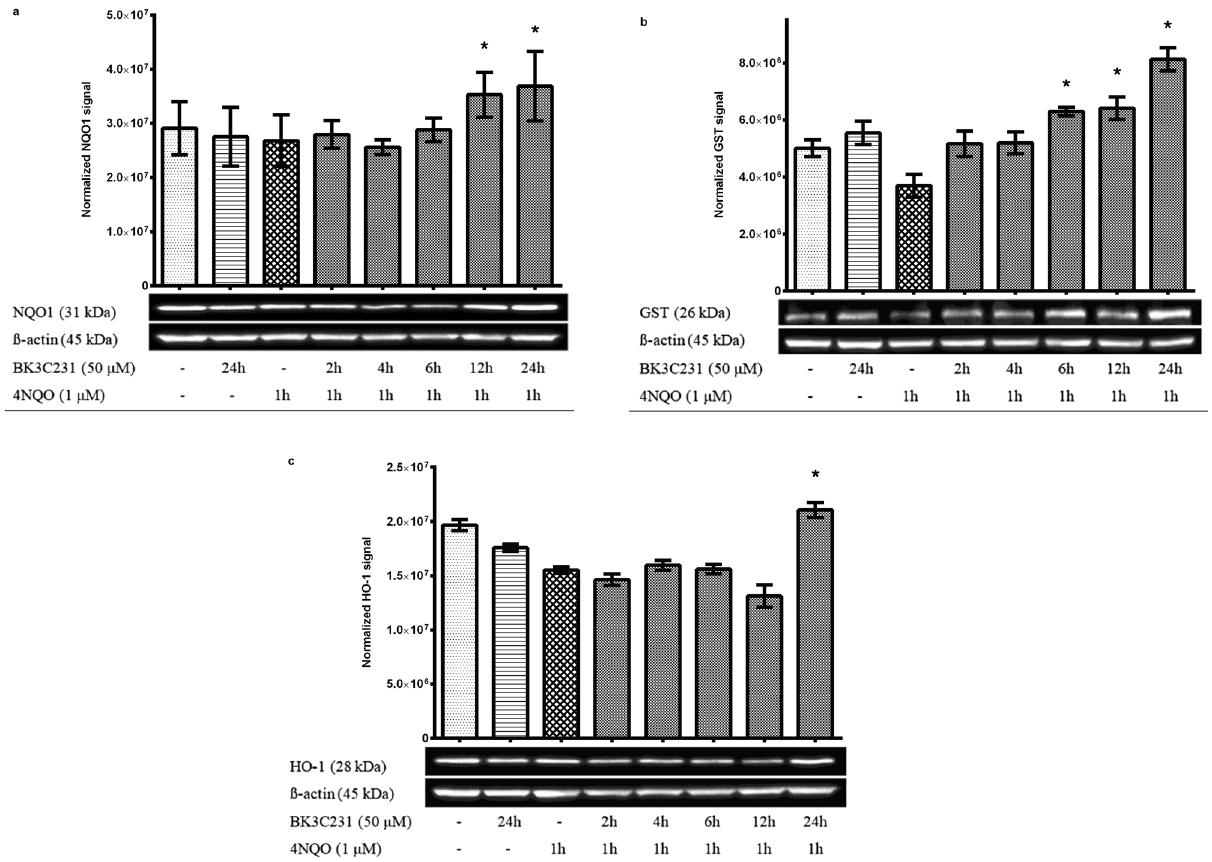
Figure 2. Effect of BK3C231 pretreatment on the protein expression of cytoprotective enzymes namely NQO1 ( a ), GST ( b ), and HO-1 ( c ). Basal-level constitutive expressions of NQO1, GST and HO-1 were observed in untreated control cells and cells treated only with BK3C231. In cells treated only with 4NQO, the expression level of cytoprotective enzymes decreased as compared to that of untreated control. Pretreatment of cells with BK3C231 before 4NQO exposure significantly increased the protein expression of cytoprotective enzymes at 12 h and 24 h for NQO1; 6 h, 12 h and 24 h for GST; and 24 h for HO-1 as compared to that of cells treated with 4NQO only. Treated whole cell lysates were subjected to immunoblotting analysis to determine the protein expression level of NQO1, GST, and HO-1. Each data point was expressed as mean ± SEM from at least three independent experimental replicates. *p < 0.05 against 4NQO 1 h. The blots displayed in the figure are cropped. Full-length blots are presented in Supplementary Figure Pretreatment of cells with BK3C231 for 24 h before 4NQO exposure significantly increased NQO1 activity up to fivefold at 74.76 ± 12.76 nmol/min/mg as compared to that of 4NQO-treated cells at 12.41 ± 2.72 nmol/ min/mg. The enhancement of the NQO1 activity level by BK3C231 was almost 2 times higher than the basal level with a value of 42.81 ± 10.65 nmol/min/mg (Fig. 1a). As for GST activity, our study demonstrated a 1.3- fold increase from 0.48 ± 0.08 µmol/min/mg in 4NQO-treated cells to 1.11 ± 0.14 µmol/min/mg in BK3C231- pretreated cells for 24 h. BK3C231 also enhanced GST activity level by up to 0.2-fold increase over basal level at 0.88 ± 0.08 µmol/min/mg (Fig. 1b). Moreover, HO-1 activity level significantly increased up to 0.9-fold from 5.30 ± 0.78 pmol/mg/h in 4NQO- treated cells to 9.93 ± 1.16 pmol/mg/h upon BK3C231 pretreatment for 24 h. HO-1 activity in BK3C231-pre- treated cells at 12 h was also restored to the basal level which was at 8.87 ± 0.55 pmol/mg/h (Fig. 1c). BK3C231 elevated protein expression of cytoprotective enzymes in 4NQO‑treated CCD‑18Co cells. Basal-level constitutive expressions of NQO1, GST, HO-1 and GCLC were observed in untreated con- trol cells and cells treated only with BK3C231 as shown in Fig. 2 and Supplementary Fig. S1. In cells treated only with 4NQO, the expression level of cytoprotective enzymes decreased by 8% for NQO1, 32.8% for GST, 21.1% for HO-1 and 24.3% for GCLC, over untreated control. Interestingly, BK3C231 pretreatment induced up to a 0.4-fold increase of NQO1 expression significantly at 12 h and 24 h in 4NQO-stimulated cells as compared to that of cells treated with 4NQO only. NQO1 expres- sion in BK3C231-pretreated cells was also 26.6% higher than the basal level observed in untreated control cells (Fig. 2a and Supplementary Fig. S2a). Cells pretreated with BK3C231 demonstrated up to 1.2-fold increase of